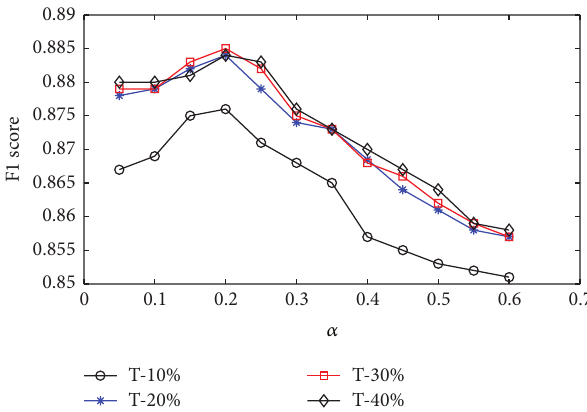
Figure 6: 𝛼 parameter selection via classification. Remark . 𝑦 -axis is the F1 measure score of our classification using different 𝛼